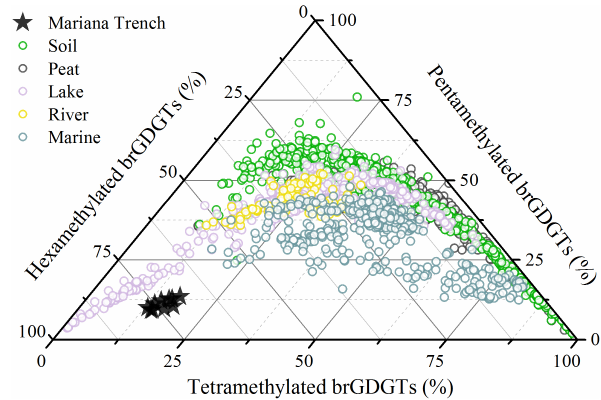
Figure 8. Ternary diagram showing the fractional abundances of tetra-, penta-, and hexamethylated brGDGTs. The compiled dataset includes globally distributed soil, peat, lake, river, and marine sam- ples, as well as the Mariana Trench